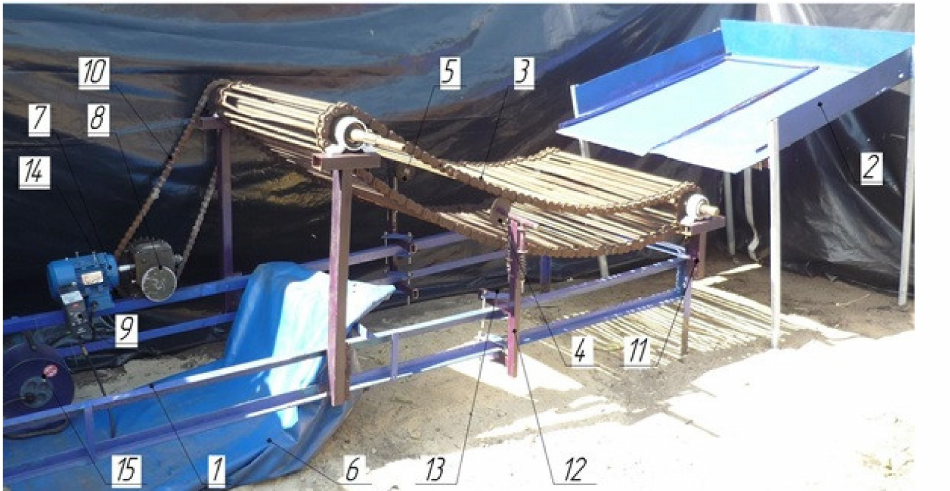
Figure 11. A general view of a laboratory installation for determining the effect of the technological parameters of a separating rod elevator on the quality indicators of the separation of a pile of root crops (bulbs): 1 frame; 2 container for preliminary placement of the pile; 3 separating rod elevator; 4 elliptical shaker; 5 supporting roller; 6 tarpaulin of separated products; 7 electric motor; 8 single stage gearbox; 9 frequency converter; 10 chain transmission; 11 support racks; 12 shaker racks; 13 connecting bracket; 14 support plate; 15 network